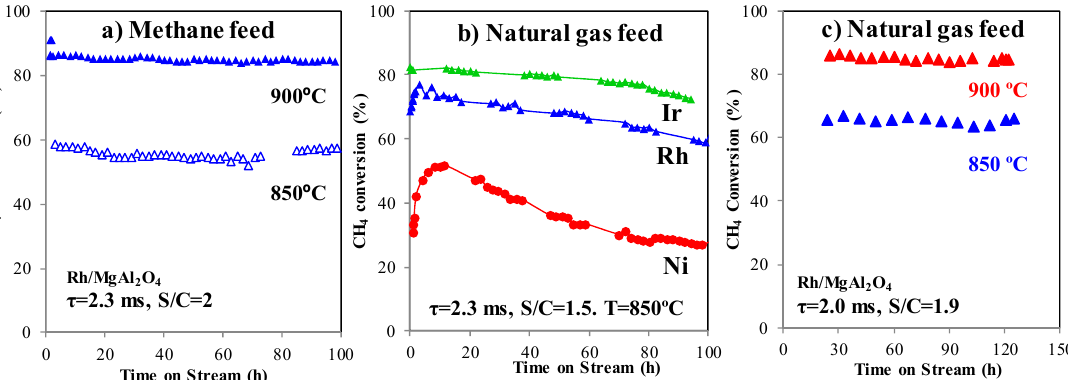
Figure 7. Methane conversion vs. time on stream (TOS) using ( a ) pure methane feed over Rh at 850 and 900 ◦ C (S / C = 2.3 ms, τ = 2.3 ms), and using natural gas simulant feed over ( b ) Rh, Ir, and Ni at 850 ◦ C (S / C = 1.5 ms, τ = 2.3 ms), and ( c ) Rh at 850 and 950 ◦ C (S / C = 1.9 ms, τ = 2.0 ms).